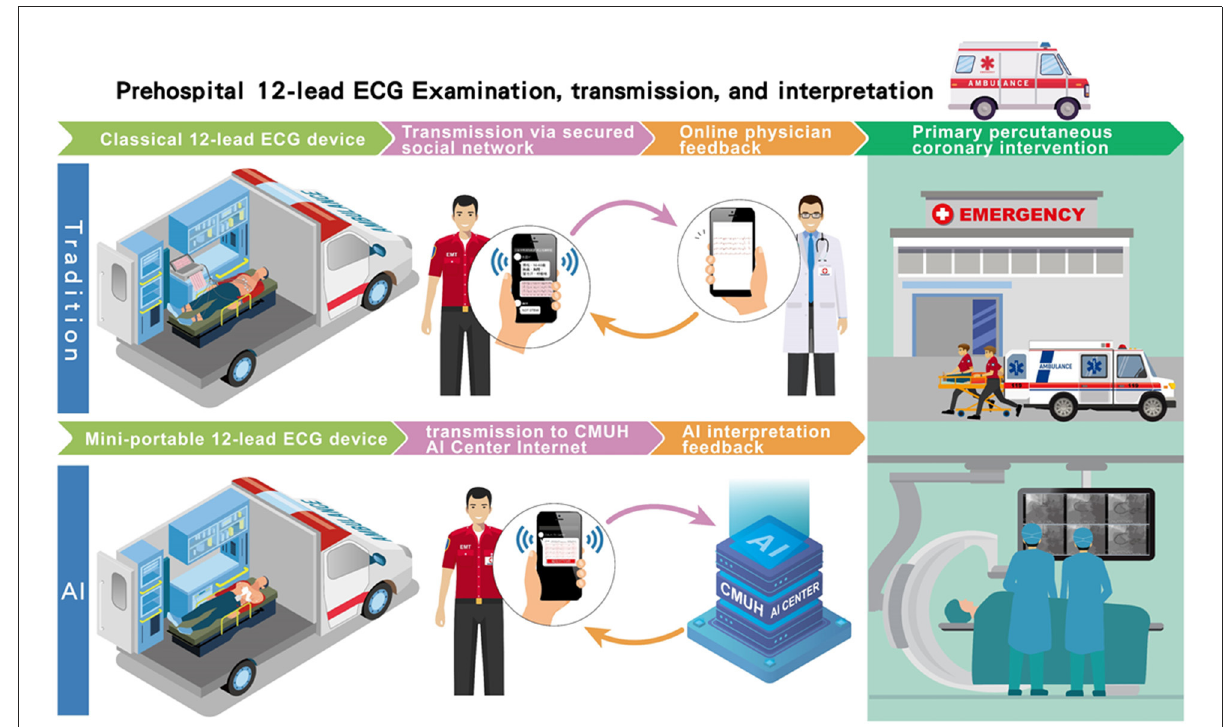
FIGURE1 The flowchart of the AI-based pre-hospital STEMI detection system. Traditionally, after the 12-lead ECG had been recorded in the ambulance vehicle, the ECG data were posted on a secured network for reading by available online physicians as had been usual practice. The time interval between ECG transmission and interpretation feedback by physicians was defined as the physician’s response time. In our AI-based pre-hospital STEMI detection system, the recorded signal was also simultaneously transmitted to the AI center of the China Medical University Hospital to be classified “STEMI” or “Not STEMI.” Similarly, the time interval between the ECG transmission and the ECG interpretation feedback by the AI was defined as the AI’s response